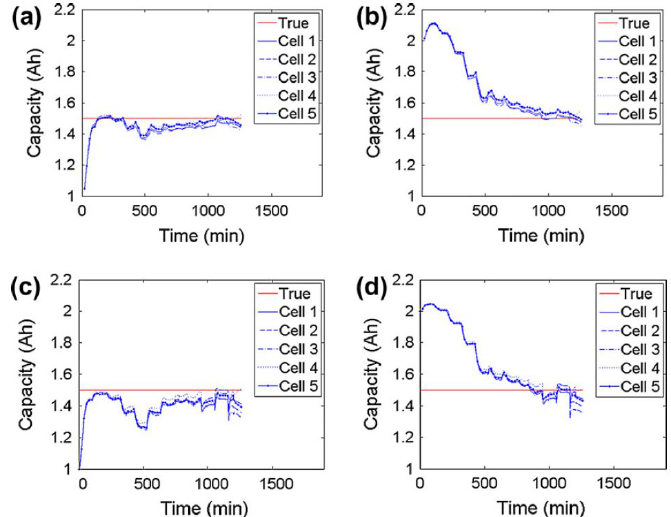
Figure 1. Battery usable capacity estimation result with the dual estimation framework [24], Copyright Elsevier, 2012. ( a , b ) are the capacity estimation result with a multi-time scale; ( c , d ) are the capacity estimation result with a single time scale. Both of these two experimental validations are tested with smaller (1 Ah) and larger (2 Ah) initial values in EKF than the true value of 1.5 Ah (Ah: